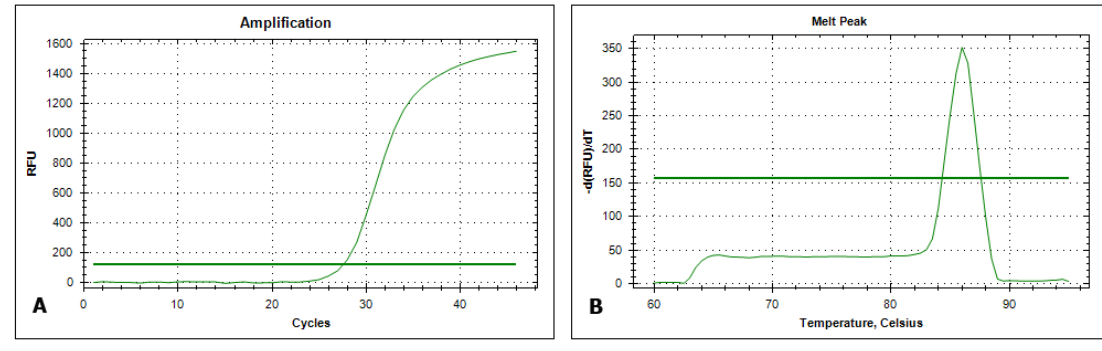
Figure 2 . Amplification plot (A) and dissociation curve (B) of the fragment, amplified by primer pair fbct2 and